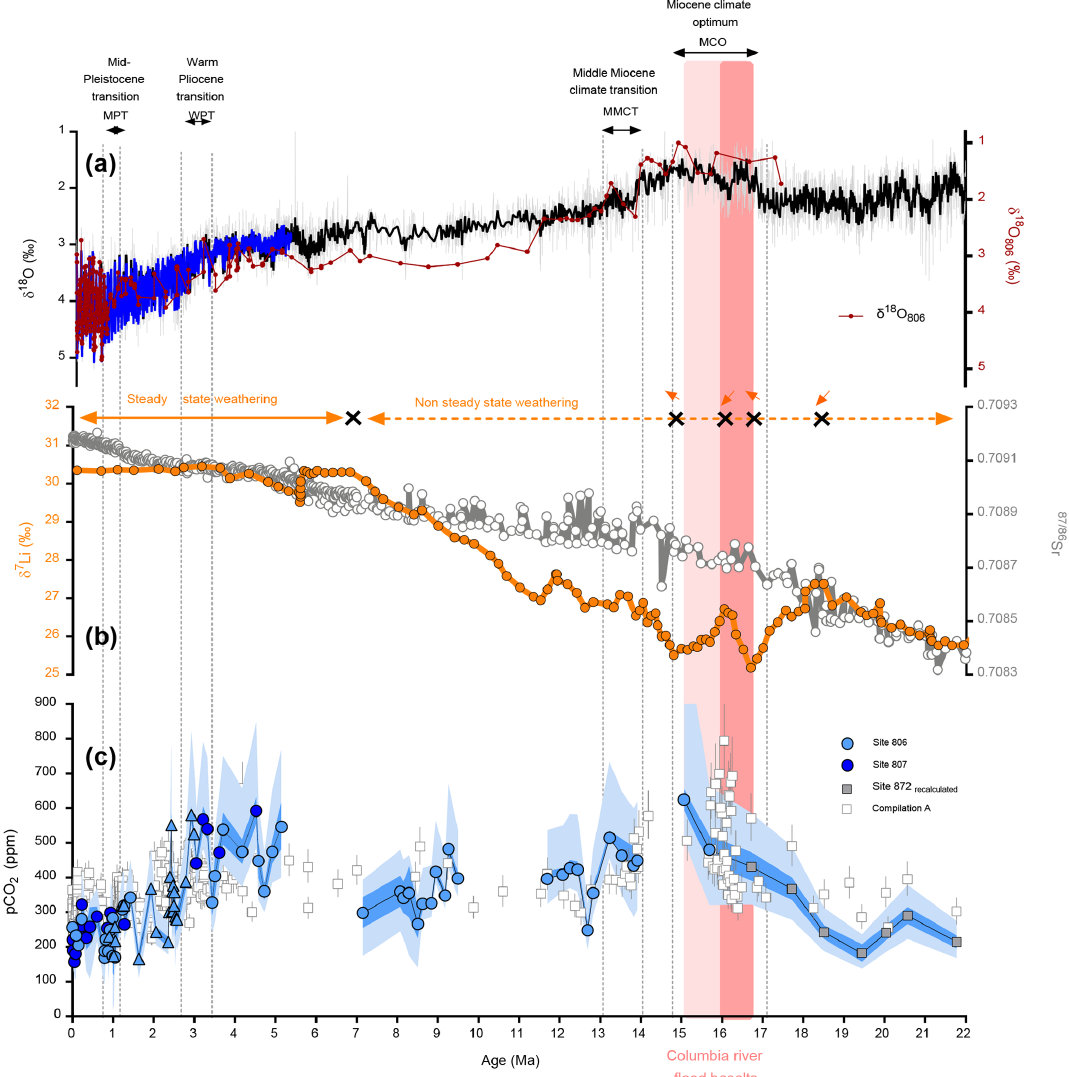
Figure 11. Proxy data from 1.5 to 0.5 million years, including the Middle Pleistocene Transition (MPT), in the Western Equatorial Pa- cific compared to benthic oxygen isotope composites. (a) Benthic δ 18 O (blue line – compilation from Lisiecki and Raymo, 2005, black line – compilation from Zachos et al., 2008). (b) Records from lithium isotopes ( δ 7 Li, orange, Misra and Froelich, 2012) and strontium isotopes ( 87 / 86 Sr, grey, Hodell and Warnke, 1991; Farrel et al., 1995; Martin et al., 1999; Martin and Scher, 2004), both proxies for silicate weathering. Orange arrows represent the different weathering regimes as indicated by the δ 7 Li, black crosses indicates when changes in weathering regime occur. (c) Reconstructed p CO 2 (ppm) using boron-based pH and alkalinity from Caves et al. (2016), color indicates the site (filled light blue = 806, filled dark blue = 807), symbols represent the species (circle = T. sacculifer and triangle = G. ruber ), filled grey squares (compilation A) are recalculated data based on Sosdian et al. (2018) at site 872. Data for compilation A are from Hönisch and Hemming (2009); Seki et al. (2010); Foster et al. (2012); Badger et al. (2013); Greenop et al. (2014); Martínez-Botí et al. (2015a); Chalk et al. (2017); Sosdian et al. (2018). Propagated uncertainties are given by Eq. (S17) for the dark blue envelope, while the light blue envelope are the uncertainties calculated based on Eq. (S16) (taking into account uncertainty on δ 11 B seawater ). Also shown is the timing of major events. The rose band and dark rose band indicate the eruption of the Columbia River flood basalts (Hooper et al., 2002) and time of maximum eruption (Kasbohm and Schoene, 2018),